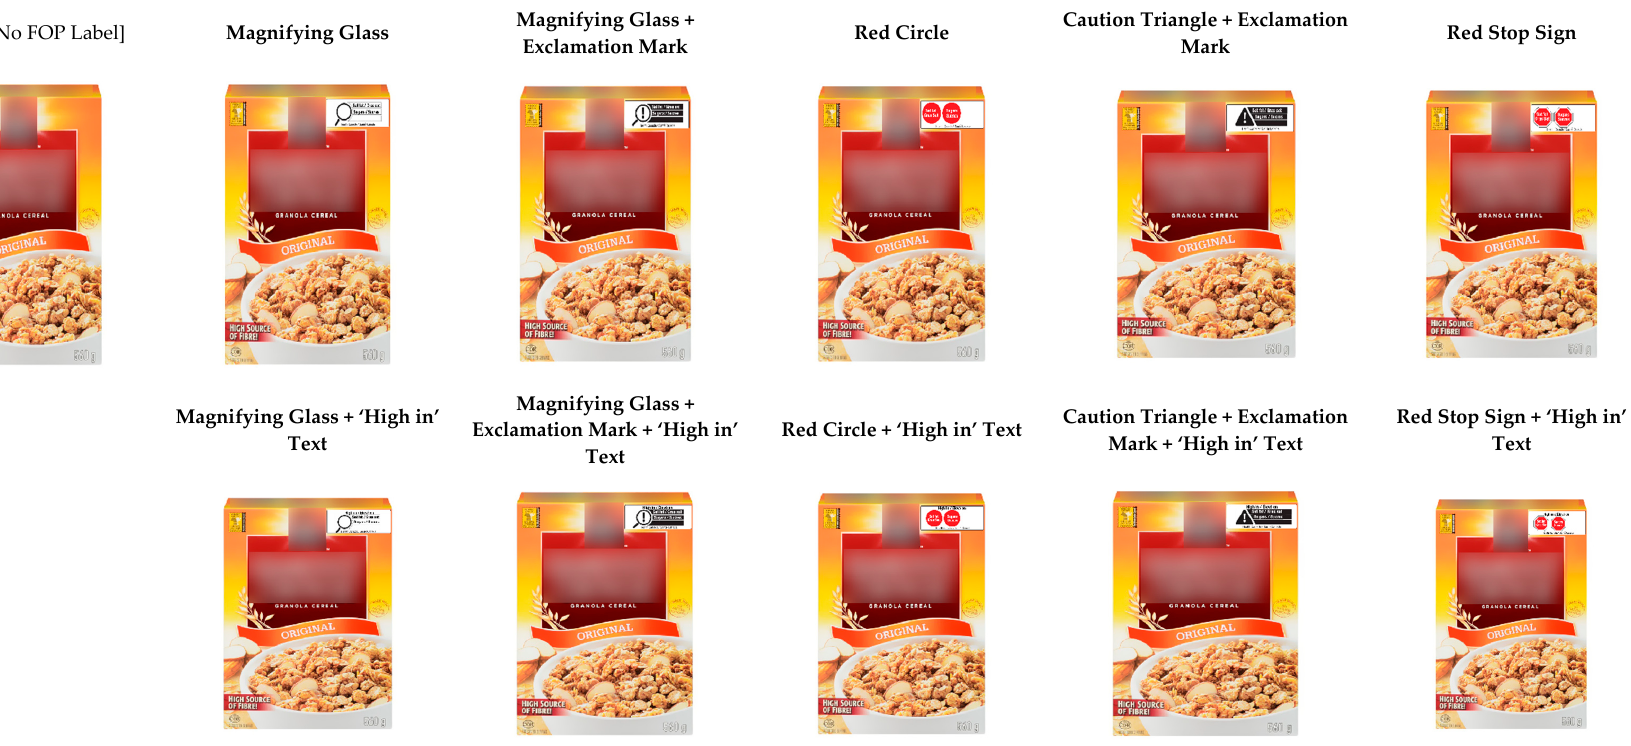
Figure 1. Images with front-of-package (FOP) labels displayed on screen for 4 s during experimental task. Note that brand names and logos have been blinded for publication but were shown to participants.